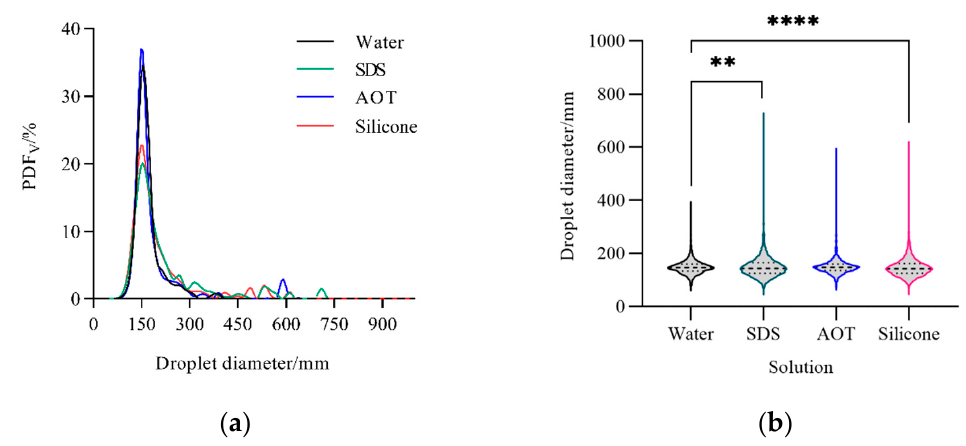
Figure 10. ( a ) Curve of probability volume density function (PDF V ). ( b ) Violin plot of drop size for the TXVK